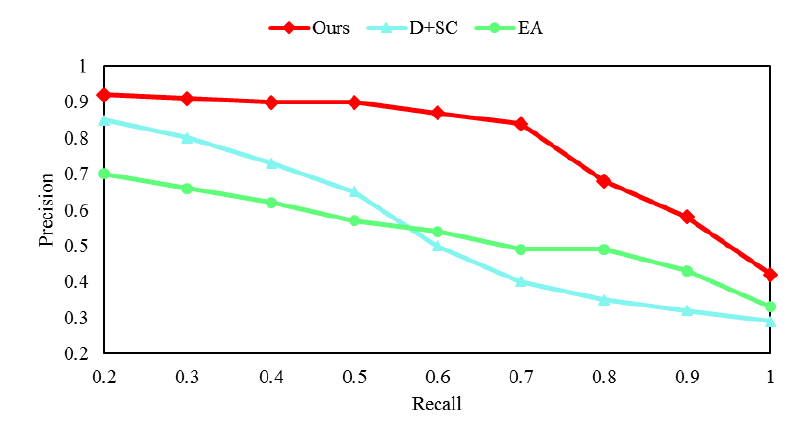
Figure 8. Precision and recall curve for the boundary extraction methods.